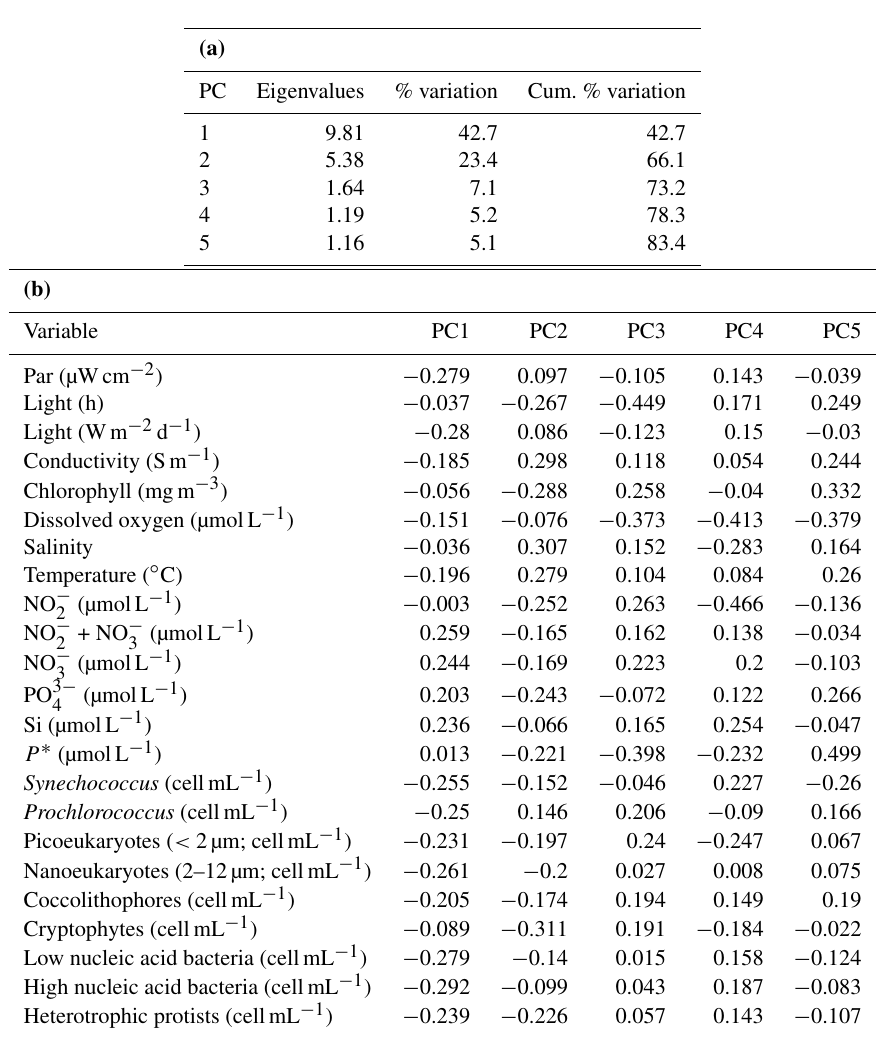
Table 1. Results of principle component analysis. Eigenvalues are presented in (a) . (b) Eigenvectors are presented, the coefficients in linear combinations of variables making up principal components